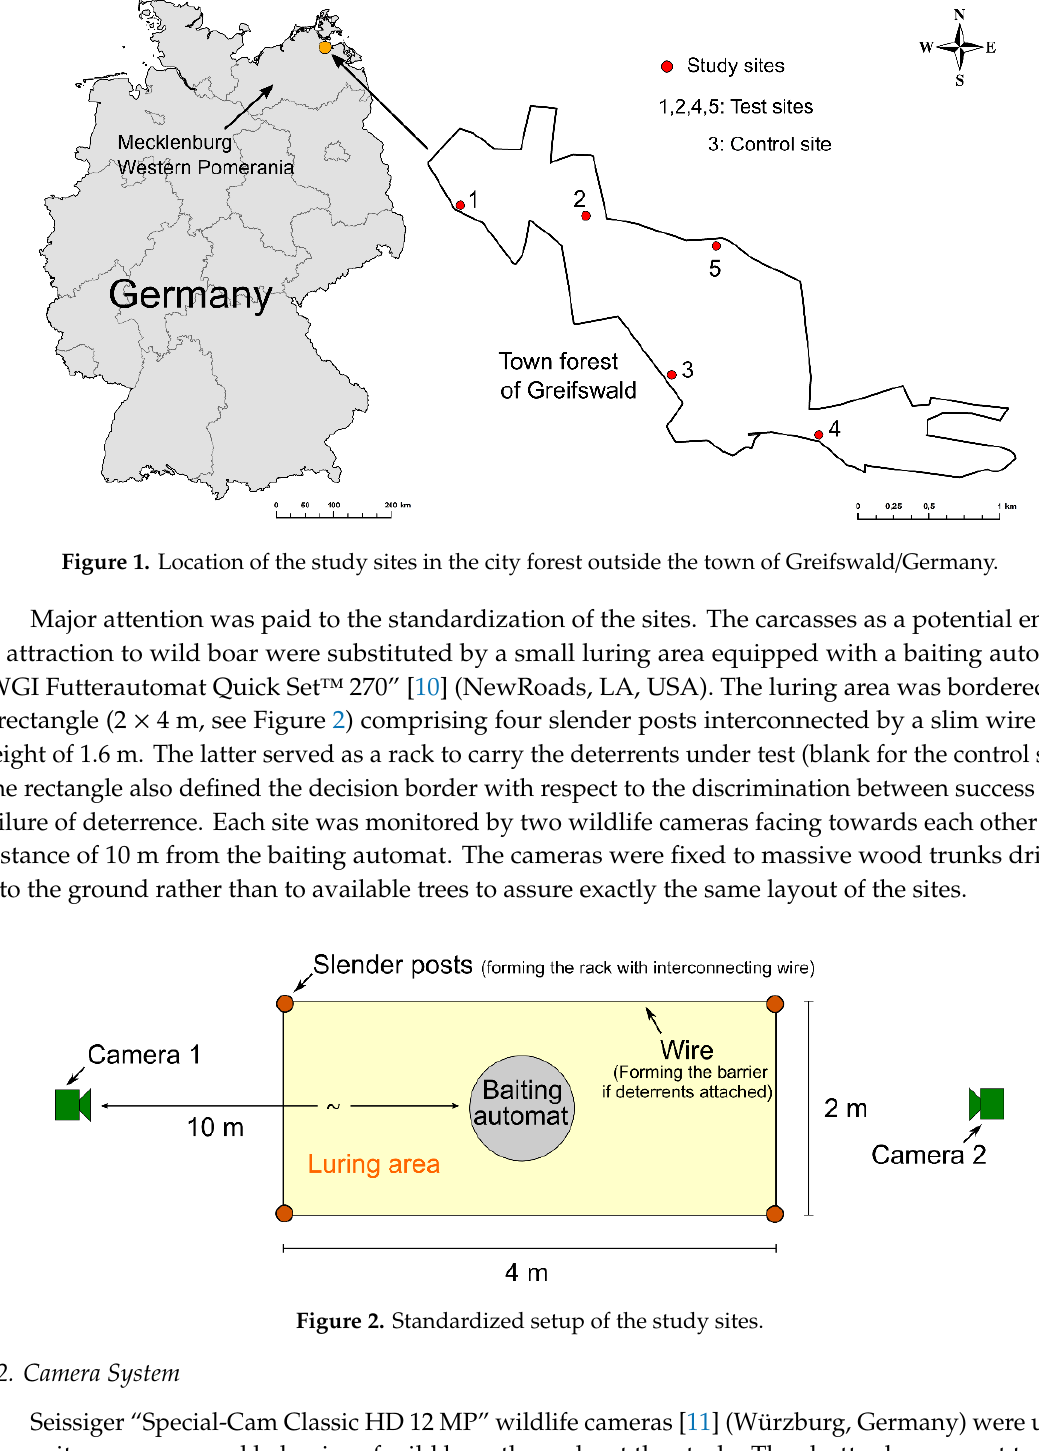
Figure 2. Standardized setup of the study sites.